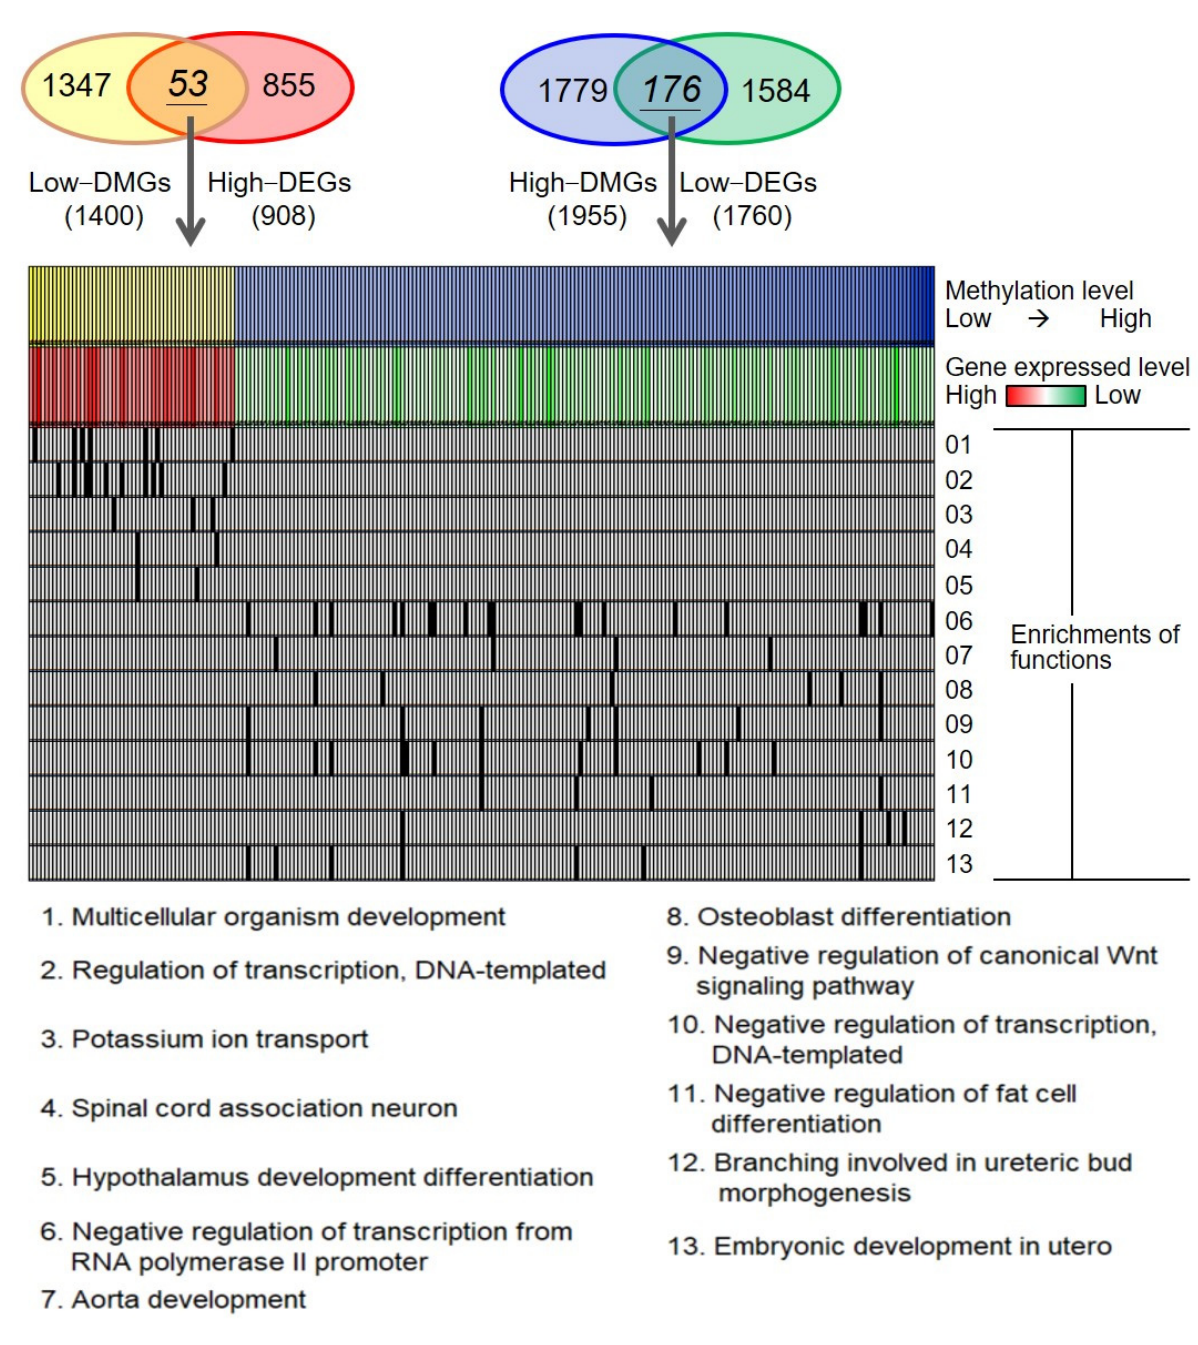
Figure 2. Functional enrichment analysis and heatmap for differentially methylated and expressed profiles. Venn diagrams show selected genes with a negative correlation between methylation and gene expression in patients with adenomyosis and controls. Items 01–05 list the enriched biological functions of 53 lowly DMGs and highly DEGs as multicellular organism development, regulation of transcription, and potassium ion transport. Items 06–13 list the enriched biological functions of 176 highly DMGs and lowly DEGs as negative regulation of transcription from RNA polymerase II promoter, aorta development, osteoblast differentiation, and negative regulation of the canonical Wnt signaling pathway. DEGs, differentially expressed genes; DMGs, differentially methylated genes.